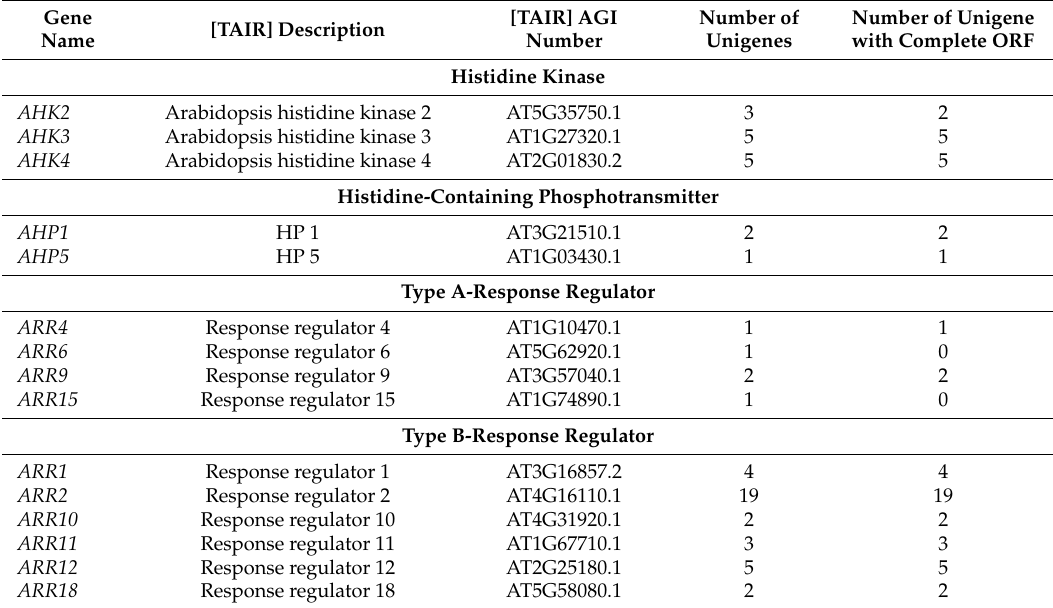
Table 3. Unigenes involved in cytokinin signal components in P. ginseng